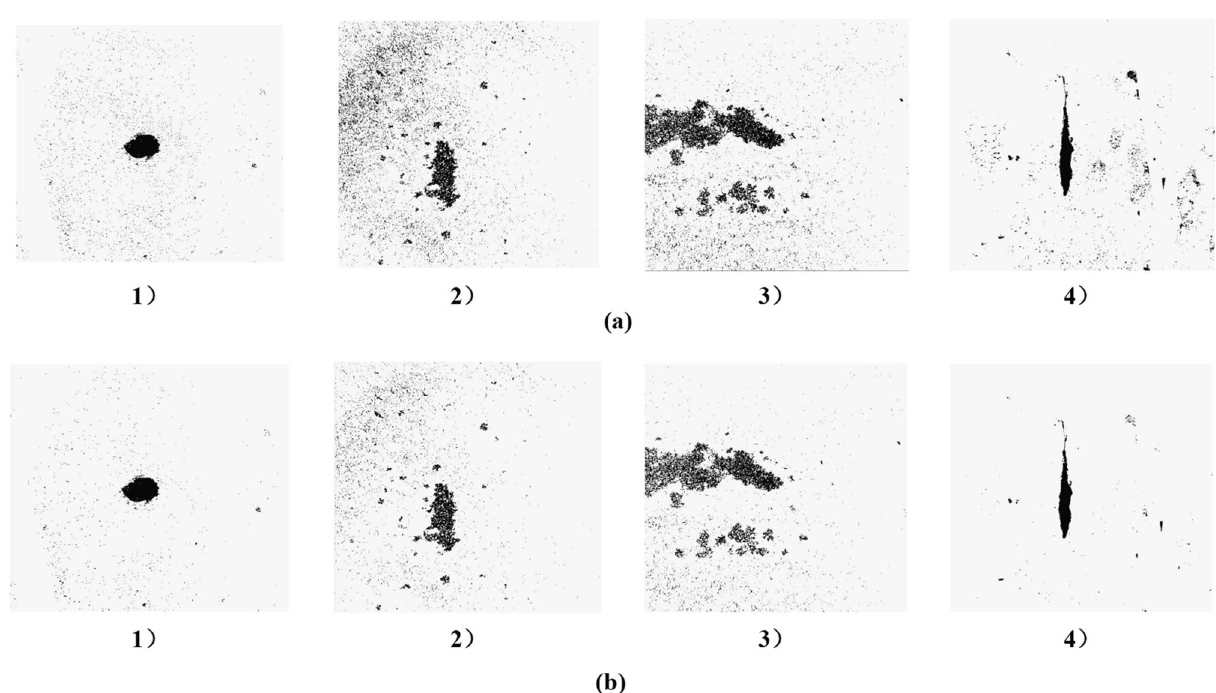
Figure 8. Image denoising ( a ) Gaussian filtering combined with morphological open operation: 1) point seepage; 2) surface seepage; 3 surface seepage; 4) line seepage; ( b ) median filter combined with morphological open operation: 1) point seepage; 2) surface seepage; 3) surface seepage; 4) line